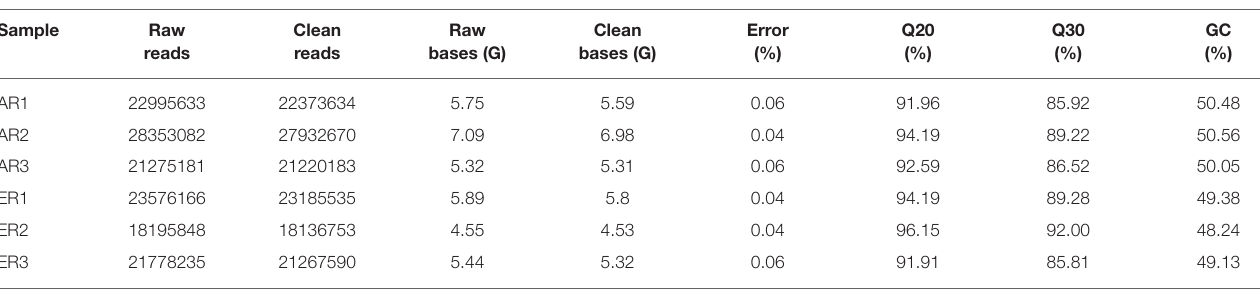
TABLE 1 | The quality of data